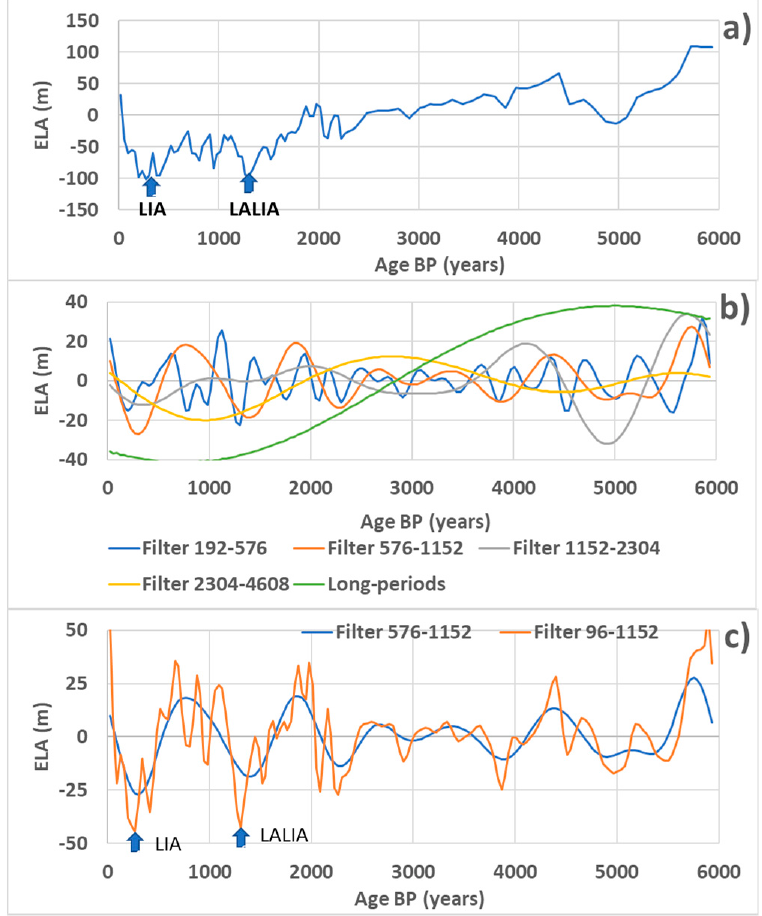
Figure 5. Equilibrium-line altitudes (ELA) of a glacier in northern Folgefonna, western Norway; ( a ) raw signal; ( b ) signal filtered in the characteristic bands of subharmonic modes n 3 = 2 2 , n 4 = 3 × 2 2 , n 5 = 3 × 2 3 , and n 6 = 3 × 2 4 (mean periods = 256, 768, 1536, and 3072 yrs) and the long-periods; ( c ) signal filtered in the band 576–1152 yrs characteristic of the subharmonic mode n 4 = 3 × 2 2 (mean period = 768 yrs), and in the band 96–1152 yrs, which includes the modes n 2 = 2 1 , n 3 = 2 2 , and n 4 = 3 × 2 2 (mean periods = 128, 256, and 768 yrs).